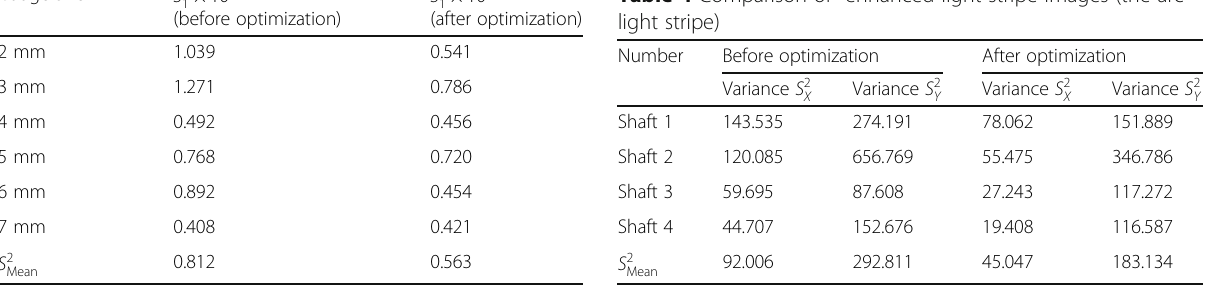
Table 4 Comparison of enhanced light stripe images (the